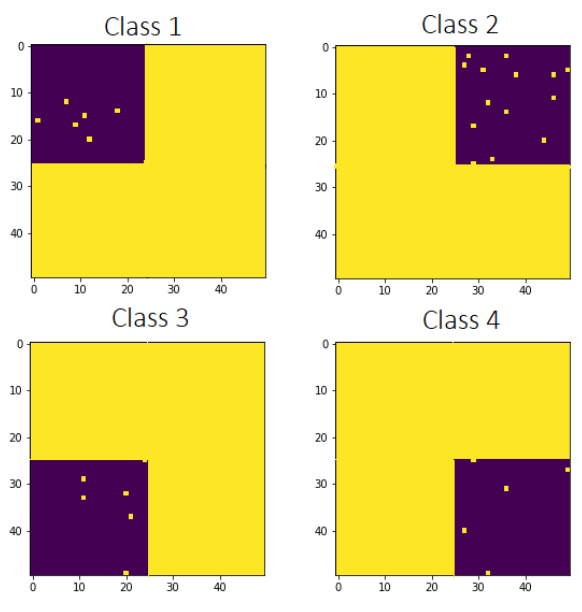
Figure 1: The piecewise MLM re-trains the MLM model class- by-class. Above is the visualisation of the re-labelled Y , where only the class we are expecting is labelled as zero (0). All the rest of the pixel spectrums, including the anomalies, are re-labelled with one (1), which means an anomaly. Zero (0): Purple, an expected spectrum, One (1): Yellow, an anomaly spectrum. The subset T is labelled similarly.